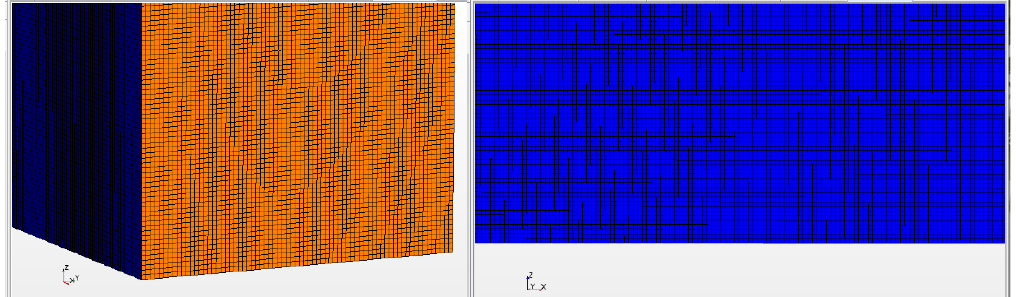
Figure 3. The computational domain meshed using a trimmed (hexahedral elements) mesh. The domain is 252-m-long, resulting in approximately 2,612,736 cells.